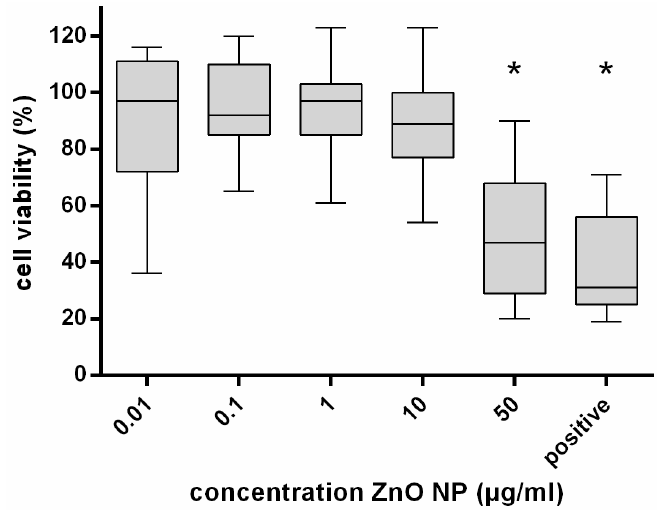
Figure 1. Viability of human mesenchymal stem cells (hMSC) after 24 h exposure to ZnO nanoparticles (NP); n = 8. The untreated control was defined as 100%. A quantity of 200 μ M tert-butylhydroperoxide (t-BHO) served as positive control. The box plots show the lowest and highest values of viable cells as well as the median. A significant decrease of hMSC viability (%) was observed after exposure to ZnO-NP concentrations of 10 and 50 μ g/mL. For statistical analysis, the Wilcoxon Test was performed. *: Statistical significance compared with the control based on a p -value < 0.05.